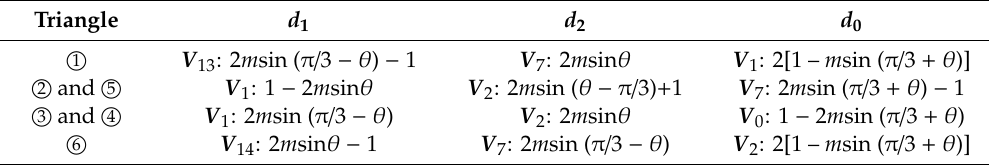
Table 4. Duty cycles of basic voltage vectors used to synthesize the reference voltage vector.